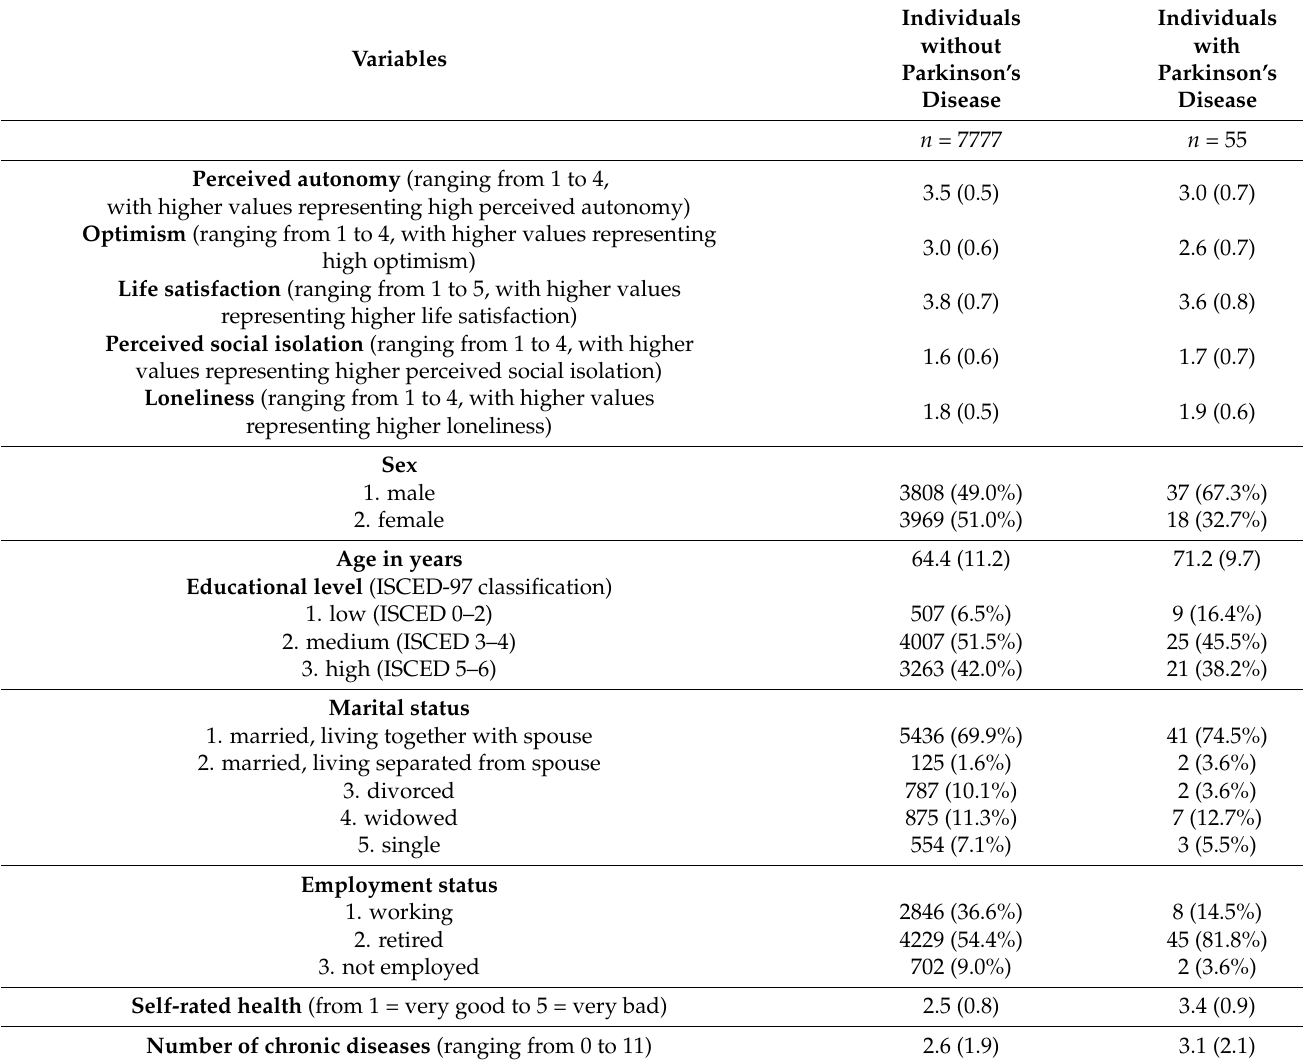
Table 1. Sample characteristics stratified by Parkinson’s disease ( n = 7832). Variables